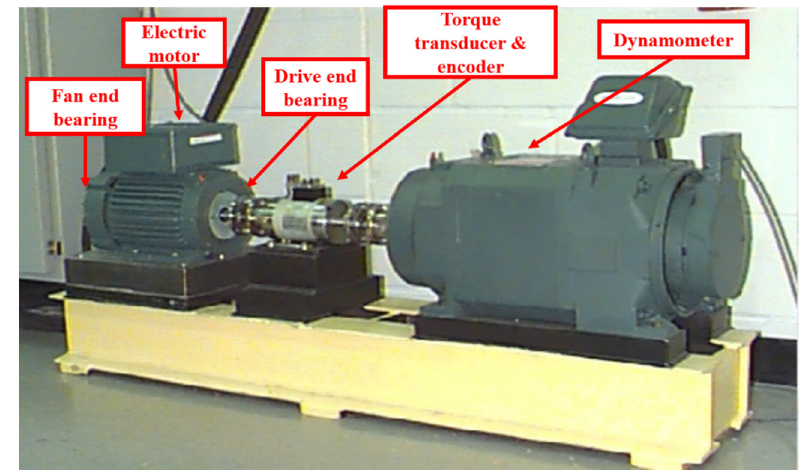
Figure 2. CWRU bearing experimental platform.